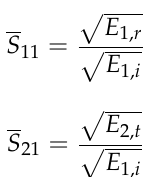
Figure 4. Absorptivity vs frequency, for SRR2. To obtain a deeper insight into the electromagnetic fields for the three baseline cases at their respective operation frequencies, Table 1 conveys the distributions of the magnitudes of electric field intensity, magnetic field intensity, and magnetic energy density for SRR1 at 6.5 GHz, SRR2 at 5.3 GHz, and SRR3 at 4.3 GHz individually. This table basically provides the numerical predictions of effects of size (L p ) on the electromagnetic resonance in the metamaterial structures. It is noted that for all the cases, higher electric field intensity is found within the slit at the center. It is because the effect of electric field concentration occurs within the slit, mainly in the dielectric layer, and the